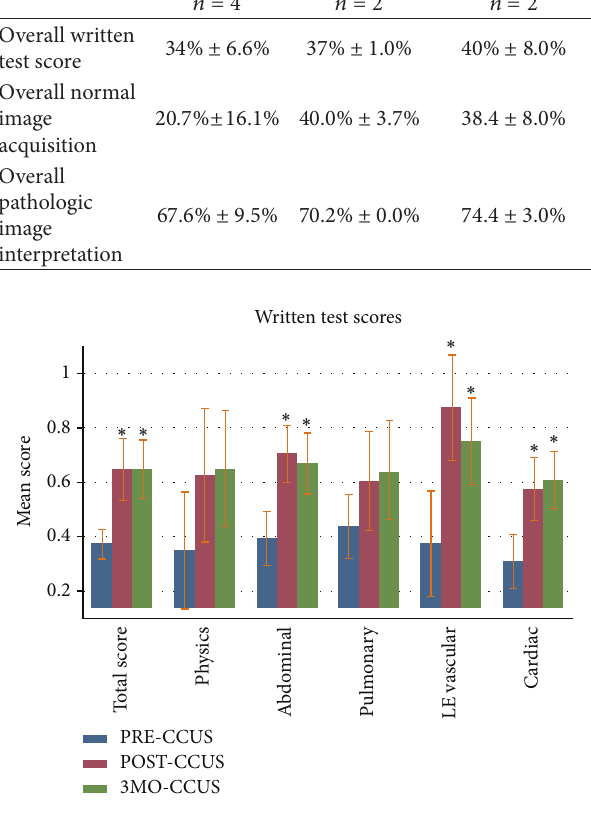
Figure 1: Written test score results with mean scores and standard deviation. “PRE-CCUS” group was tested within 1 week before CCUS course, “POST-CCUS” group was tested within 1 week after CCUS course, and “3MO-CCUS” group was tested 3 months after CCUS course. LE: lower extremity. ∗ Statistical significance when compared to the PRE-CCUS group.